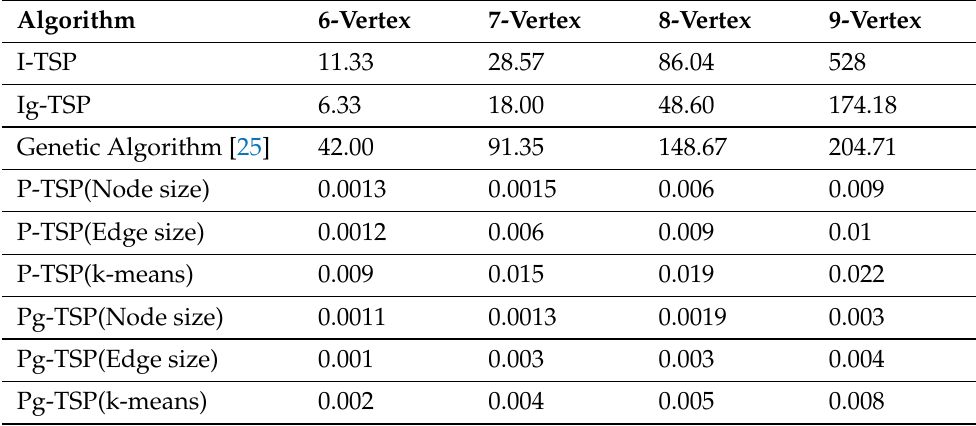
Figure 21. Supersteps in Pg-TSP for a varied number of partitions. Table 3. Run-time